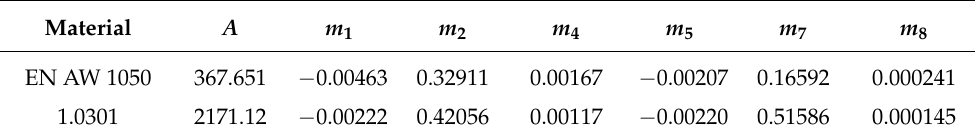
Table 2. Coefficients of the Hensel-Spittel model for the components of the roll bonded composite: A : material constant; m 1 to m 8 : coefficients considering the influence of the current deformation conditions on the flow